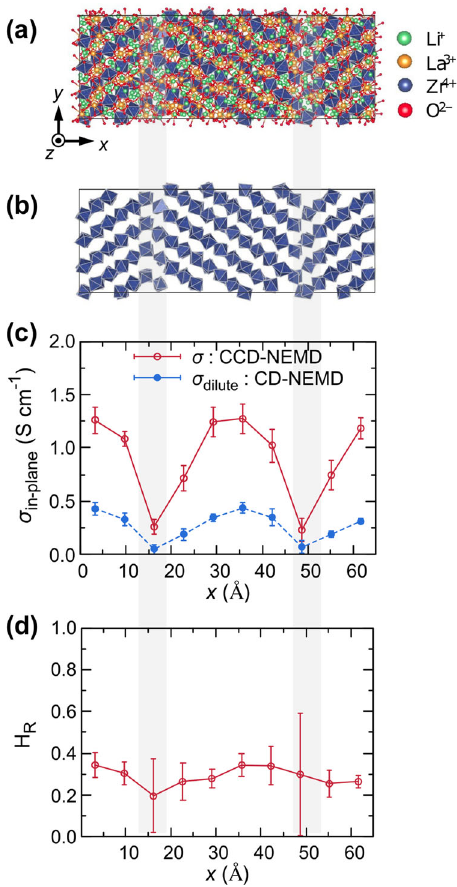
Fig. 6 Structures and grain-boundary ionic conductivity of the Σ 3(112) grain boundary of LLZO. Structures of the Σ 3(112) grain boundary of LLZO depicting a all atoms and b only the Zr atoms. c Position-dependent ionic conductivity of the Σ 3(112) grain- boundary structure of LLZO obtained via CCD-NEMD ( σ ) and CD- NEMD ( σ dilute ). d Position-dependent Haven ratio ( H R ). The values and error bars indicate the average and standard deviation of the fi ve independent samples with different initial